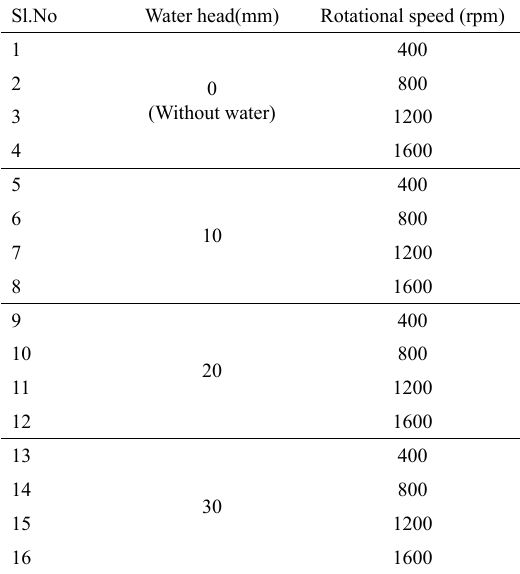
Table 1. Combinations of weld parameter Sl.No